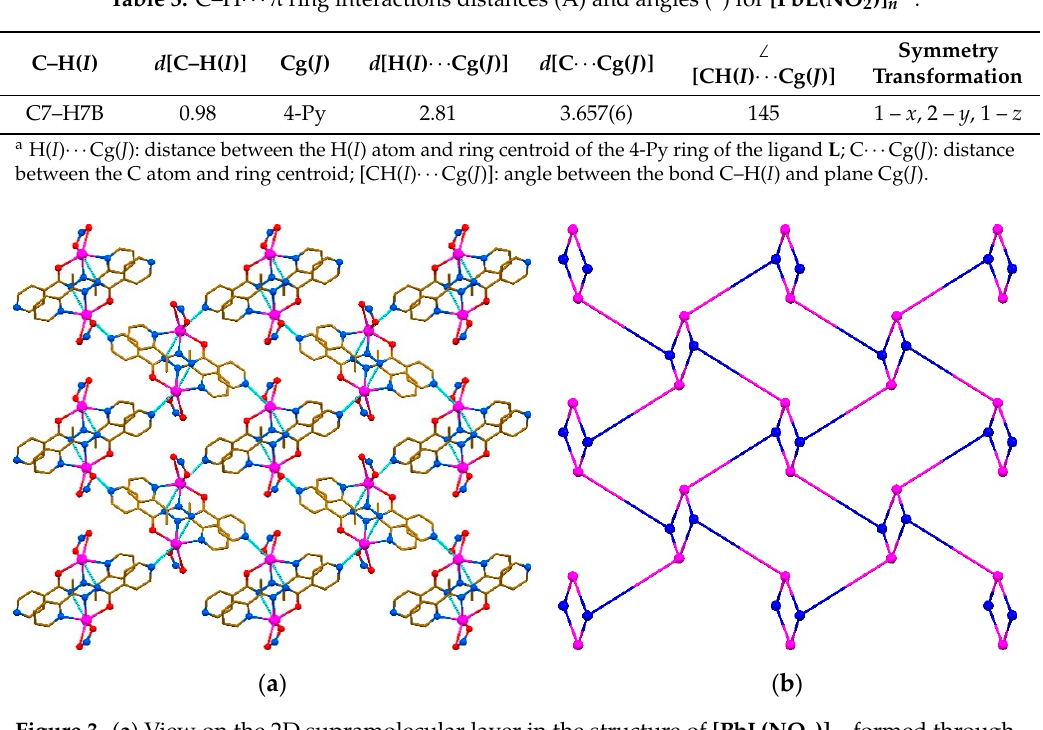
Table 3. C–H ⋯ π ring interactions distances (Å) and angles (°) for [PbL(NO 2 )] n a .